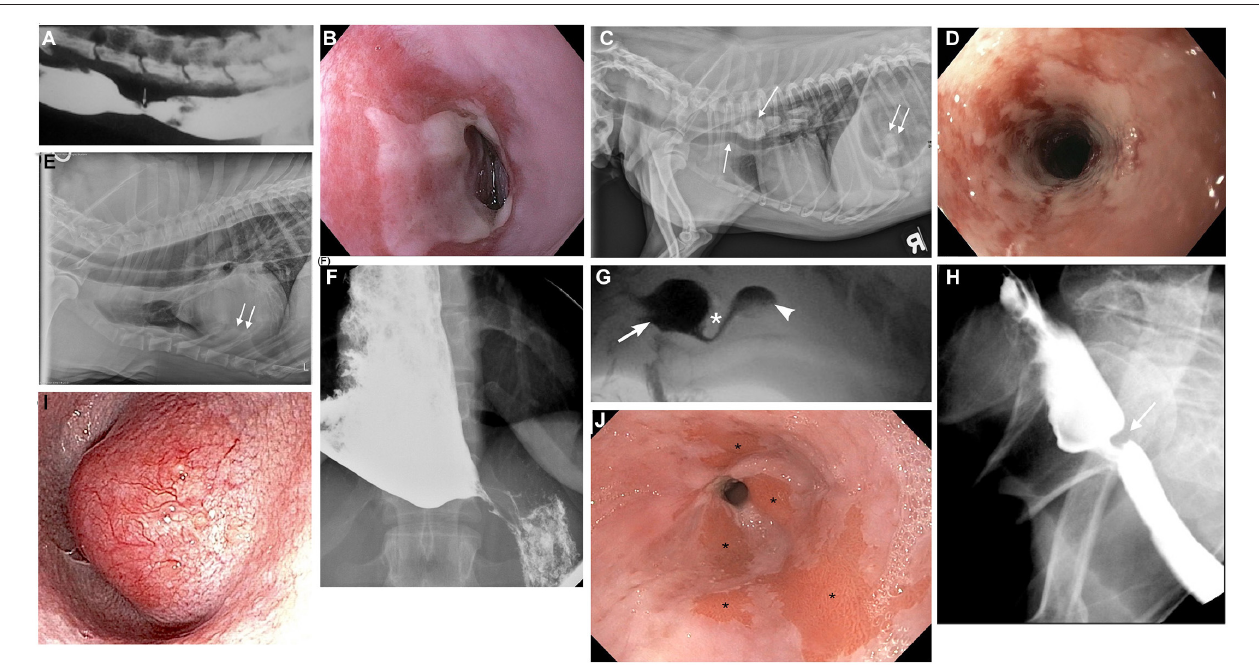
FIGURE 4 | Canine and human esophageal disorders. (A) Contrast esophagram study performed in lateral recumbency in a 2-year old mixed breed dog documenting a focal esophageal stricture (arrow) secondary to severe gastroesophageal reflux. (B) Endoscopic image of a peptic stricture secondary to gastroesophageal reflux in a 58-year-old human patient. (C) Survey lateral thoracic radiograph of a 7-year old mixed breed dog with multiple fragments of a pork bone lodged in the thoracic esophagus (downward arrow). The mineral fragments are distending the esophagus and even ventrally deviate the trachea (upward arrow). There are also a few mineral fragments seen in the gas-dilated stomach (double arrow). (D) Severe ulcerative esophagitis and an esophageal stricture in a 48-year old human patient with a history of gastroesophageal reflux. (E) Right lateral survey thoracic radiograph of a 3-year old male Viszla with a 3-week history of regurgitation, ptyalism, and dysphonia. The esophagus is diffusely gas-distended (arrow) and there are ventral interstitial to alveolar infiltrates within the left cranial and right middle lung lobes (double arrows) consistent with aspiration pneumonia. The dog was diagnosed with focal myasthenia gravis and the megaesophagus resolved with pyridostigmine treatment of the myasthenia gravis. (F) Anterior-posterior contrast radiographic image of a 35-year old human patient with a sigmoid megaesophagus secondary to achalasia. The distal esophagus is distended with barium contrast, but the contrast column narrows into a classic bird’s beak shape at the esophagogastric junction due to failed relaxation of the lower esophageal sphincter. (G) Videofluoroscopic still image from a 7-month-old spayed female miniature Dachshund with severe dysphagia secondary to cricopharyngeal achalasia. A hypertrophied cricopharyngeus muscle (cricopharyngeal bar) is seen (asterisk), which obstructs bolus passage of the barium liquid from the pharynx (arrow) into the proximal esophagus (arrowhead). The barium column seen below the asterisk is attenuated as it flows through the narrow opening of the upper esophageal sphincter (UES). (H) Videofluoroscopic still image from a 78-year-old human patient with a cricopharyngeal bar. A